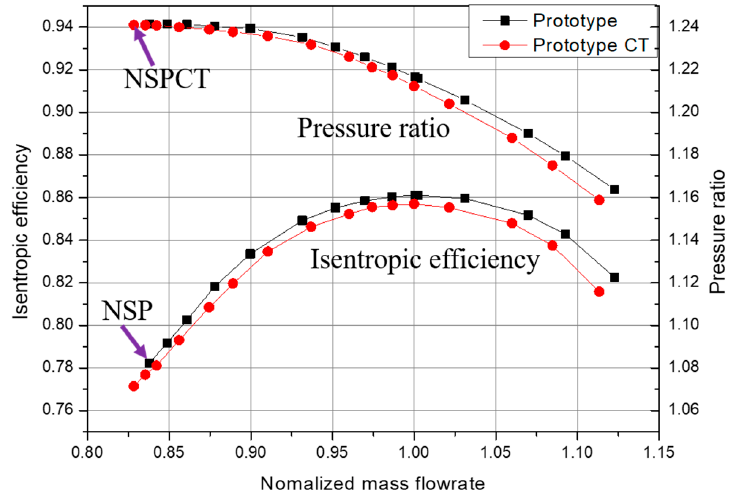
Figure 18. Pressure ratio and isentropic efficiency of the smooth solid wall and grooved casing treatment.